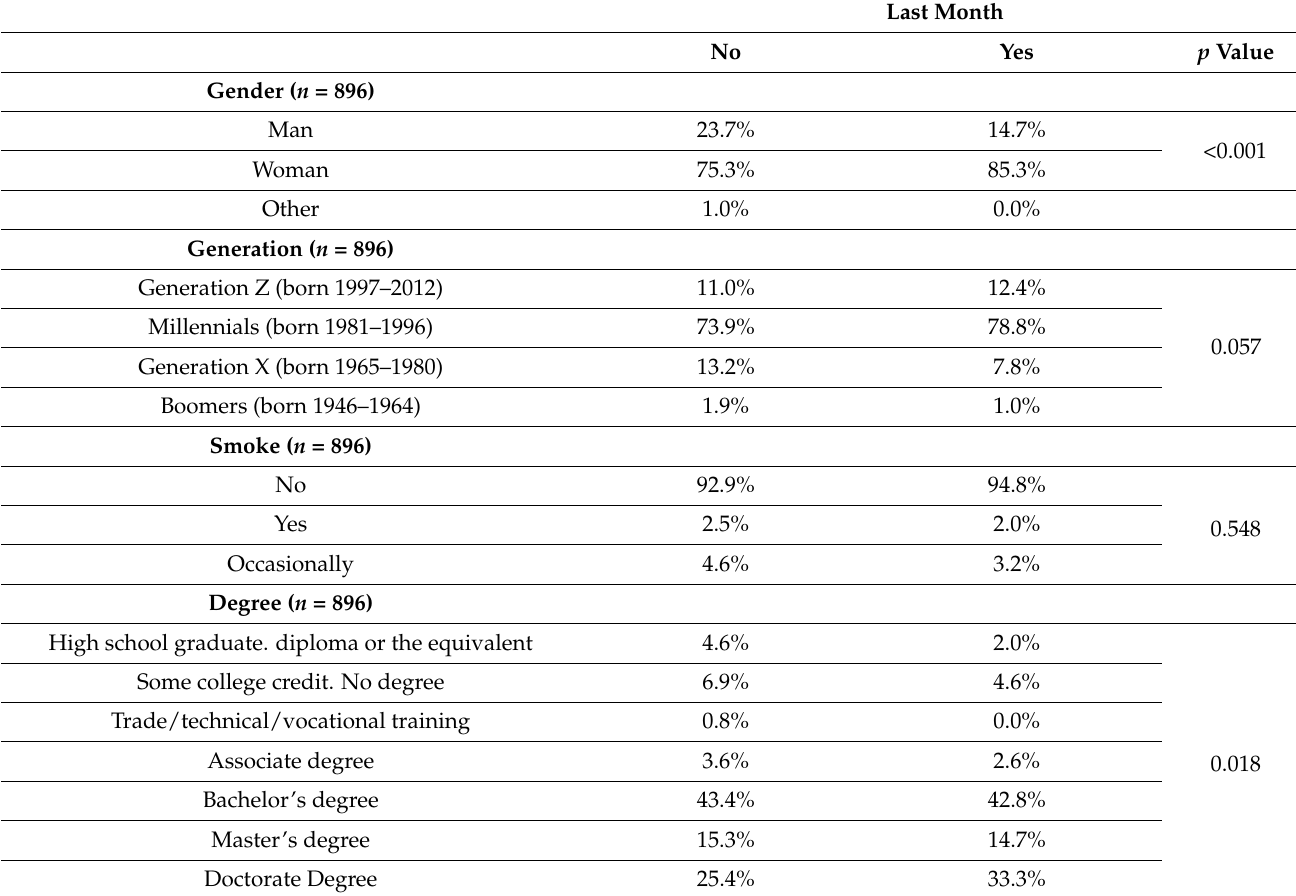
Table 1. Comparative analysis of the participants depending on the usage of any meal tracker platform to record food intake over the last